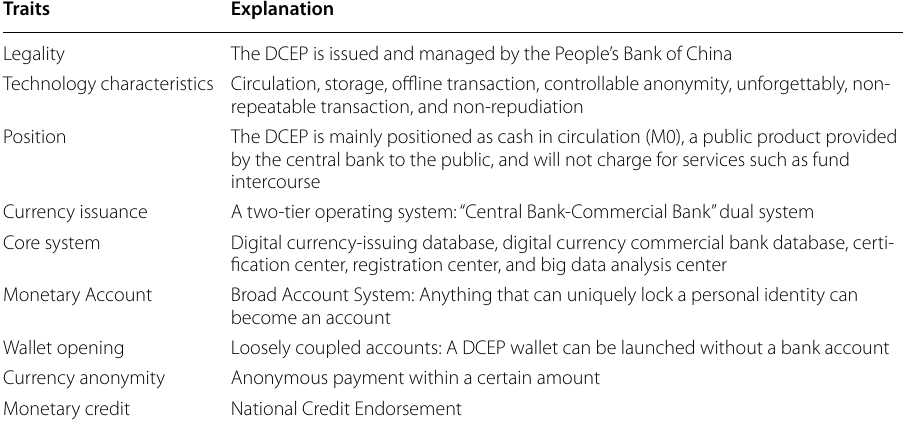
Table 2 Characteristics of DCEP Traits Explanation Legality The DCEP is issued and managed by the People’s Bank of